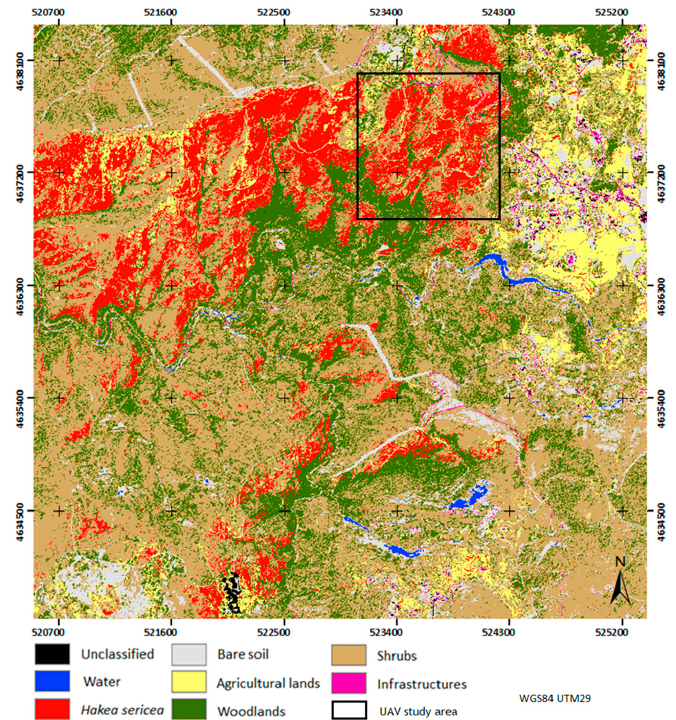
Figure 3. Map of land cover classes using WorldView-2 (WV2) (15 February 2012) and dataset “Basic 3”. Note: Hakea sericea is mapped in red. The study area covered by the UAV imagery has been included for comparative purposes. Remote Sens. 2017 , 9 , 913 11 of 17